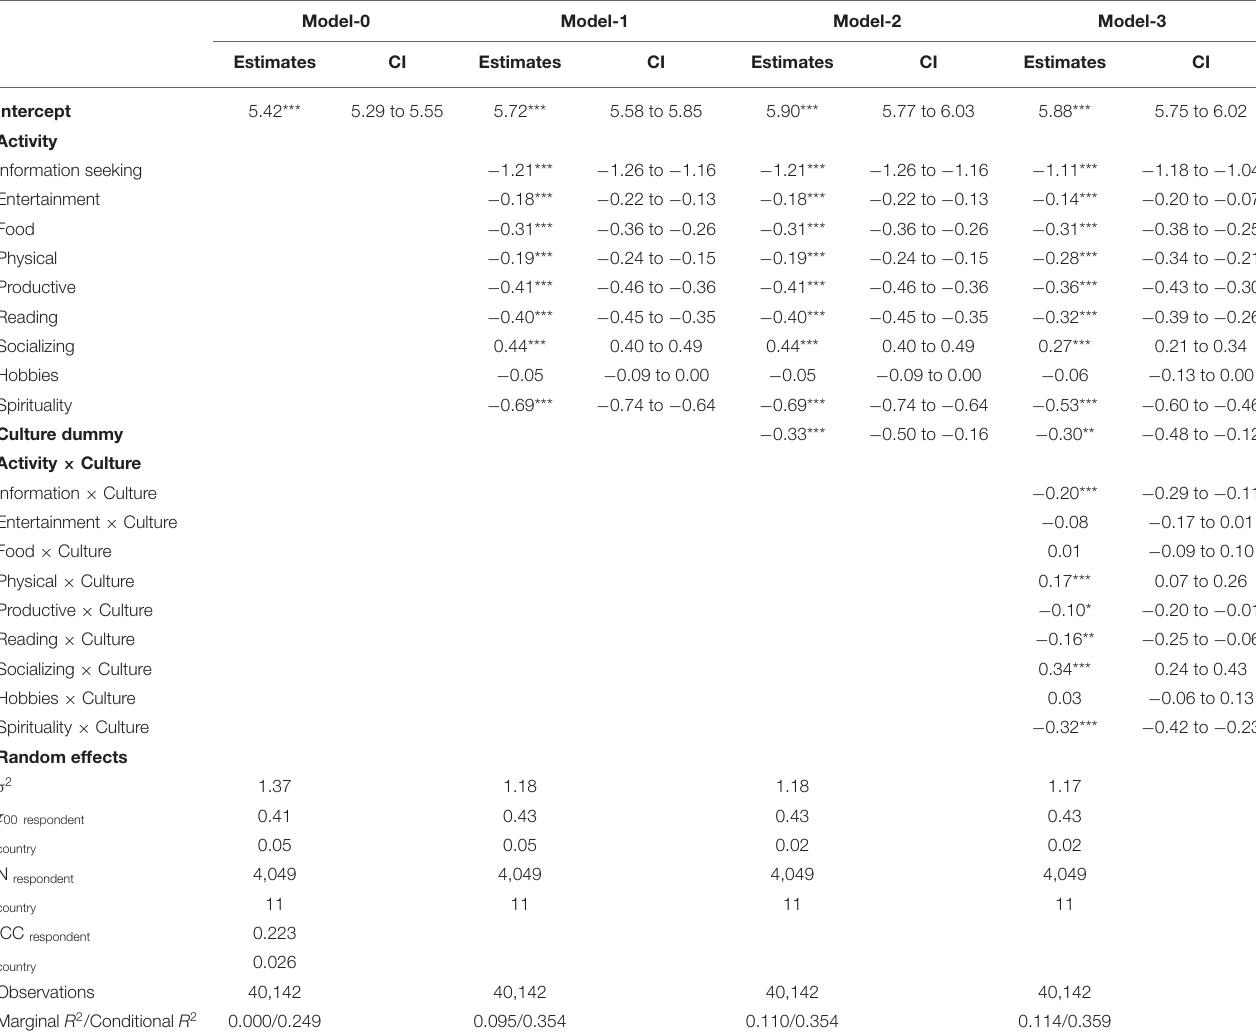
TABLE 4 | Overview of main statistical outcomes of multilevel regression models testing the efficiency of activities in “Reducing Loneliness and Creating a Sense of Togetherness” by Activity and